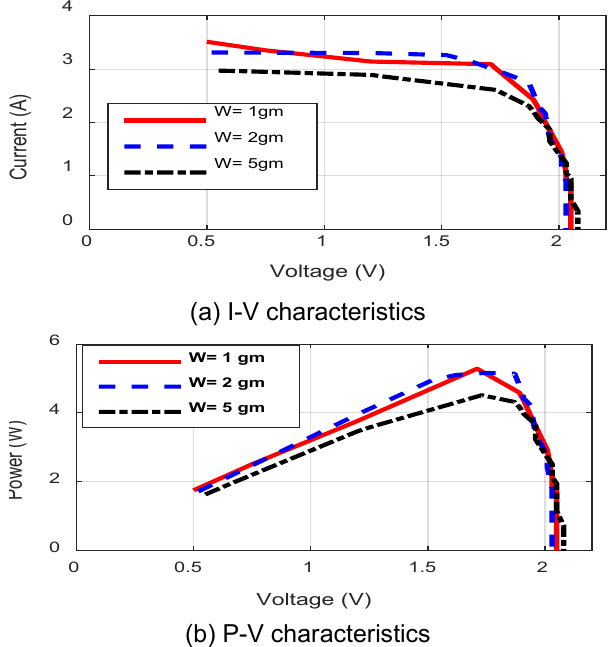
Figure 10. I-V and P- V characteristics with sugar mill Bagasse dust at 300W/m 2 Above electrical performances curves are used to calculate the FF, power and other electrical parameters for the considered PV module. Due to the dust effect, reduction in power is observed with increase in the dust weight. Table 4 shows the calculated FF at different weights and